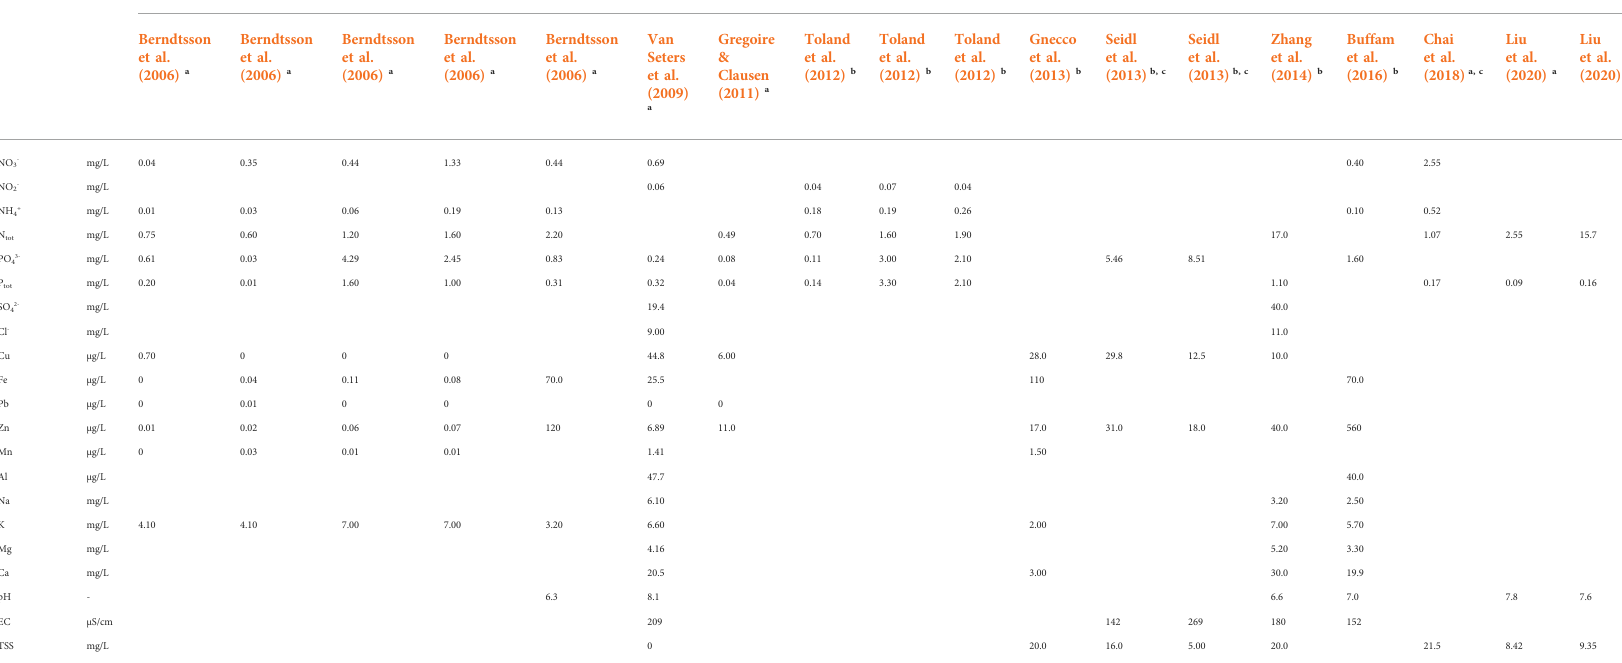
TABLE 9 Values of different parameters in green roof runoff. Parameter Unit Mean / Median values in roof runoff